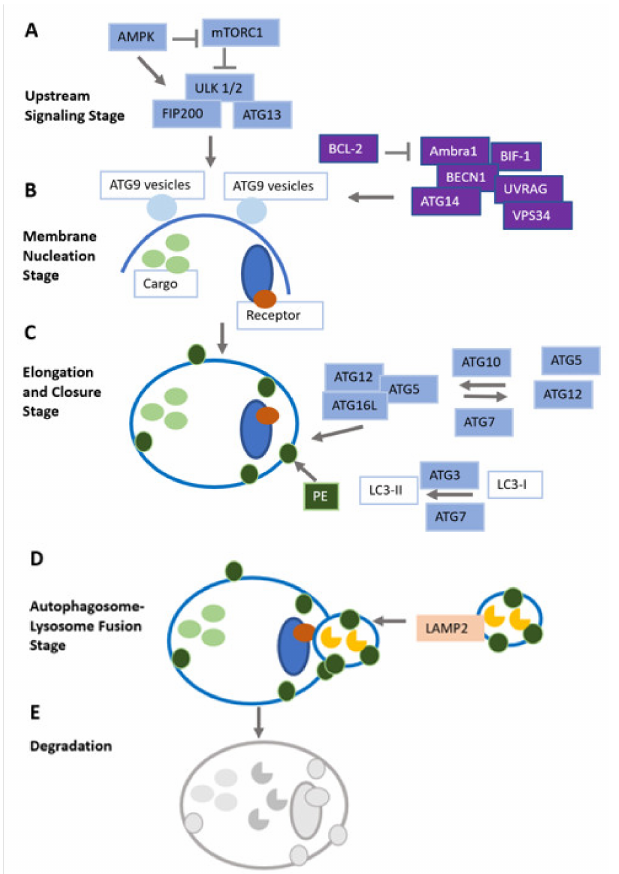
Figure 2. ( A ): Autophagy signals mostly converge at the level of mTOR protein complexes, which are regulated by AMPK. mTORC1 may limit autophagy by inactivating ULK1/2; ( B ): The class III phosphatidylinositol 3-kinase (PI3K) complex mediates the membrane nucleation stage and the initial building of the phagophore; ( C ): The elongation and closure stage depends on two ubiquitin-like conjugation systems. In the first system, ATG12 links to ATG5, mediated by ATG7 and ATG10. Next, ATG16L1 and ATG12-5 are recruited which results in the formation of a larger protein complex. Consecutively, lipid molecules are conjugated by ATG12-5-16L1 oligomers, serving as E3 ligases. Lipid-conjugated ATG8 is a prerequisite for the elongation and closure stage; ( D ): After autophago- somes fuse with late endosomes or lysosomes, they can exert their full lytic capacity; ( E ): Following the integration of the outer membranes of autophagosomes, cell cargo located in the inner membrane is degraded by lysosomal hydrolases. Figure adapted after Kocaturk et al.